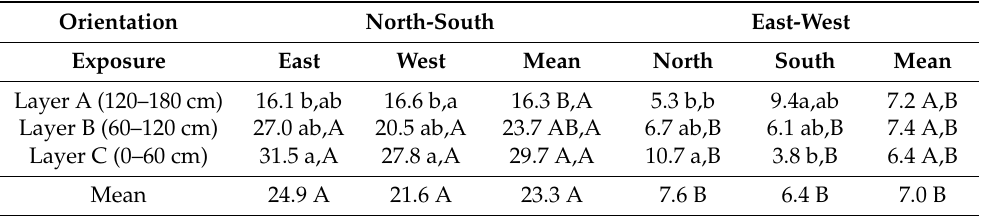
Table 3. Mean number of flower buds per shoot (FB). The first letters denote significant differences between layers for a given exposure; the second letters denote significant differences between exposures for a given layer (SNK test). Lower case letters denote statistical differences with p = 0.05. Capital letters denote statistical differences with p =